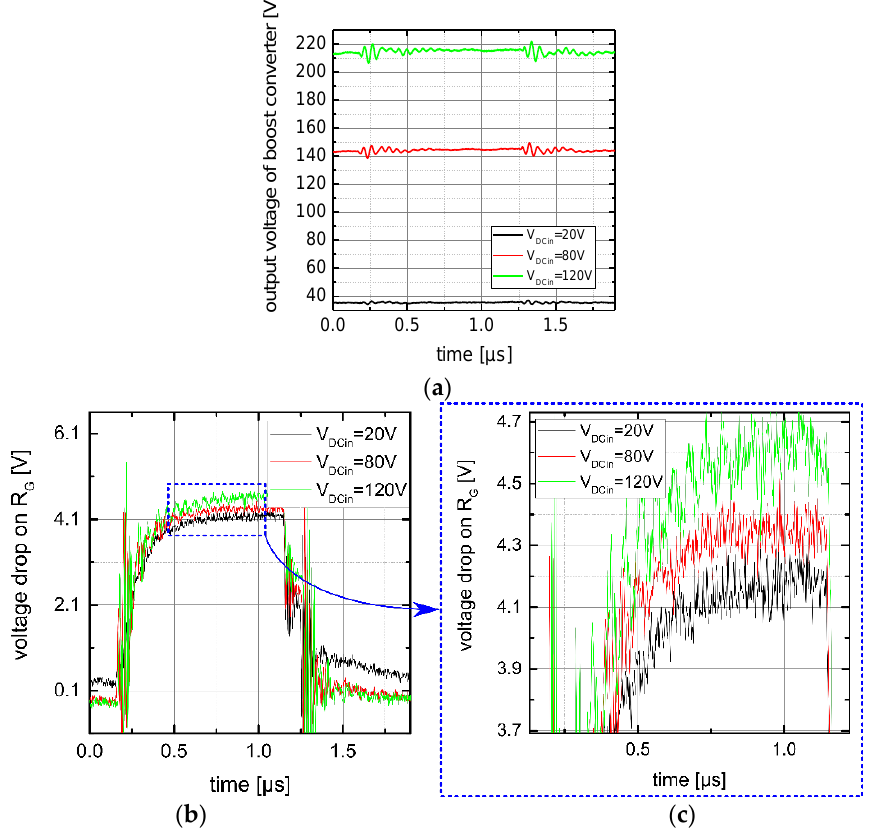
Figure 11. Waveforms associated with the synchronous step-up converter based on Ohmic-gate p-GaN HEMTs. ( a ) Output voltage of the boost converter, ( b ) voltage drop on the gate resistor, and ( c ) magnified view during the on-phase.